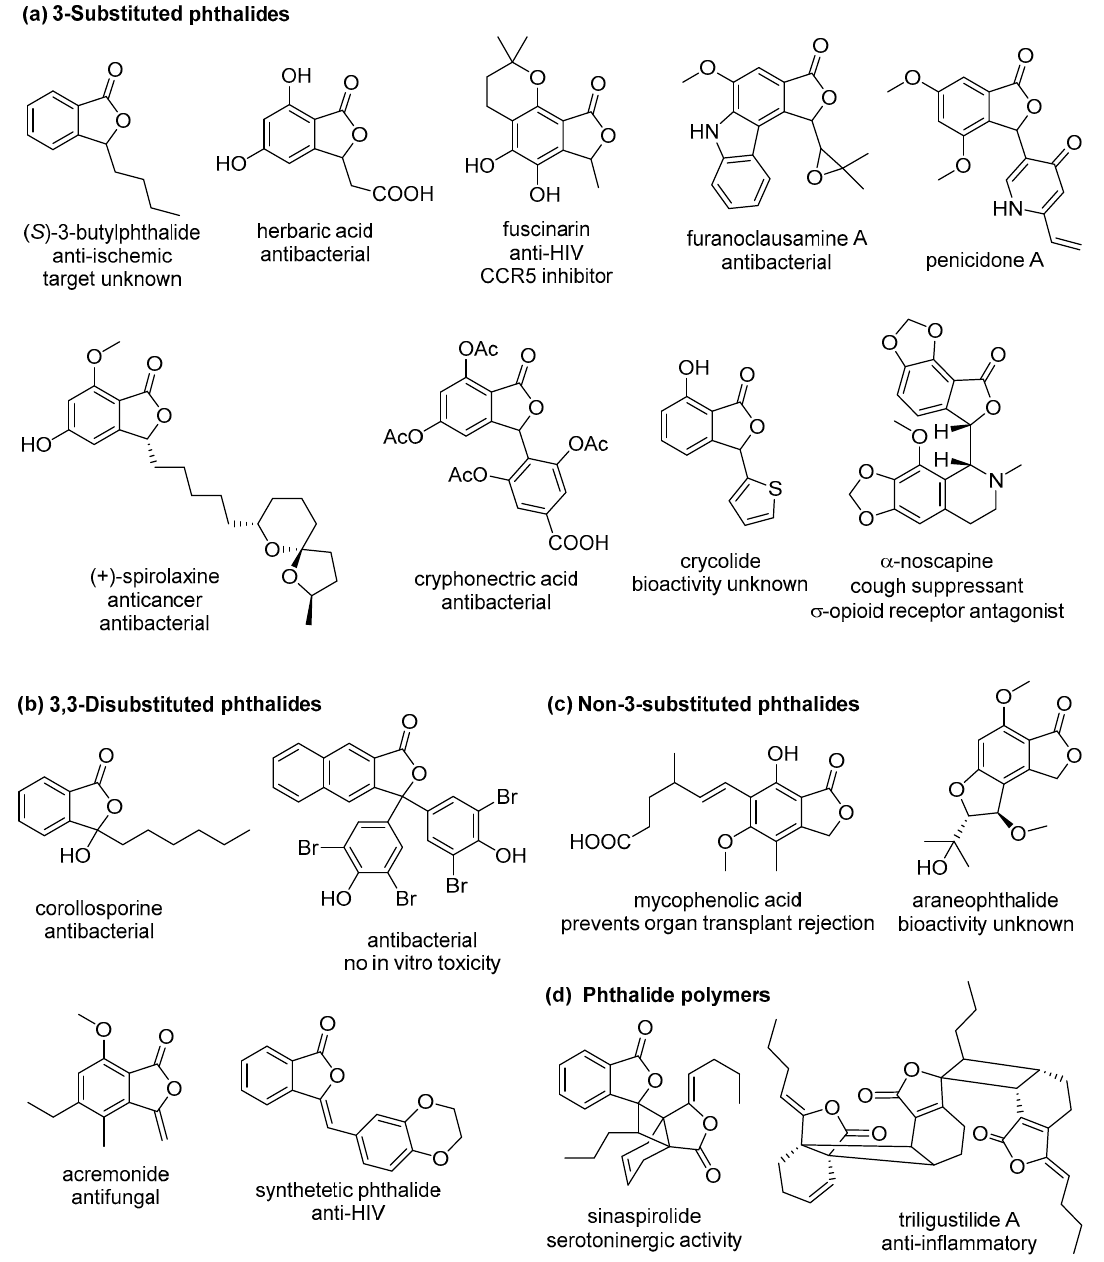
Figure 1. Representative examples of biologically active phthalides.